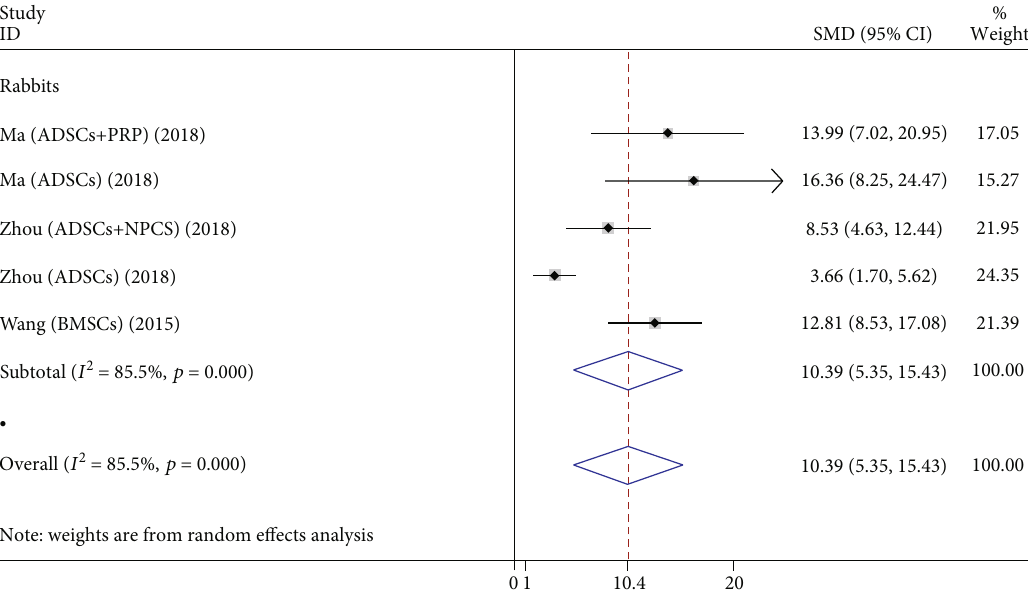
Figure 6: Forest plot showing the e ff ect of stem cell group and control group on MRI signal score in animal models. Study ID SMD (95% CI) Rabbits